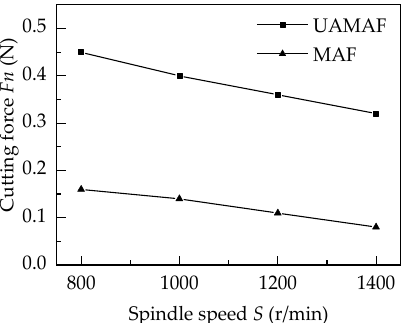
Figure 10. The relationship between spindle speed and cutting force.